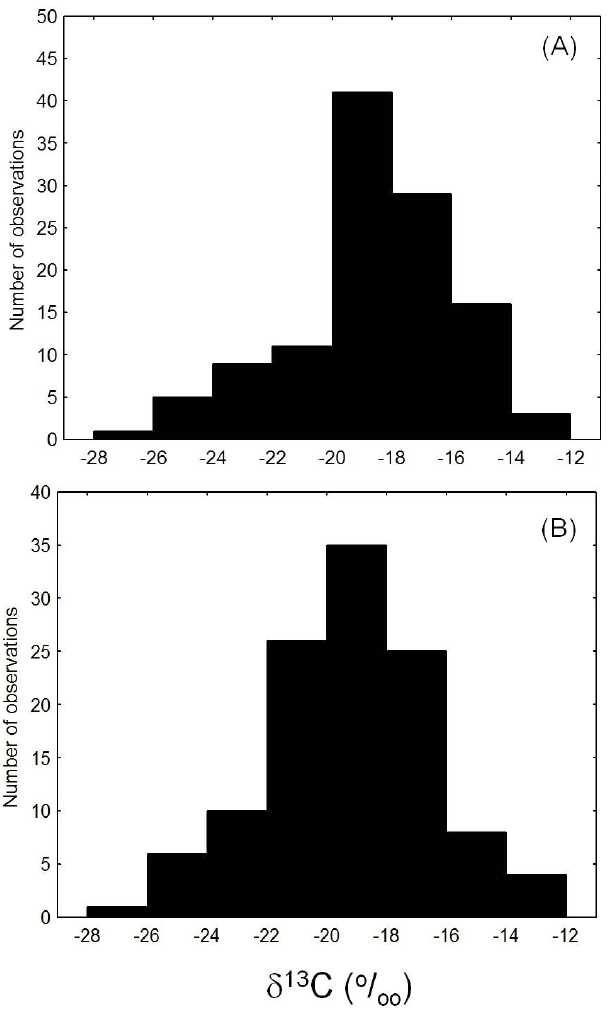
Fig. 4. Histograms of (A) the δ 13 C of soil organic matter in the pasture sites at 0–10cm depth interval and (B) at 0–30cm depth interval.